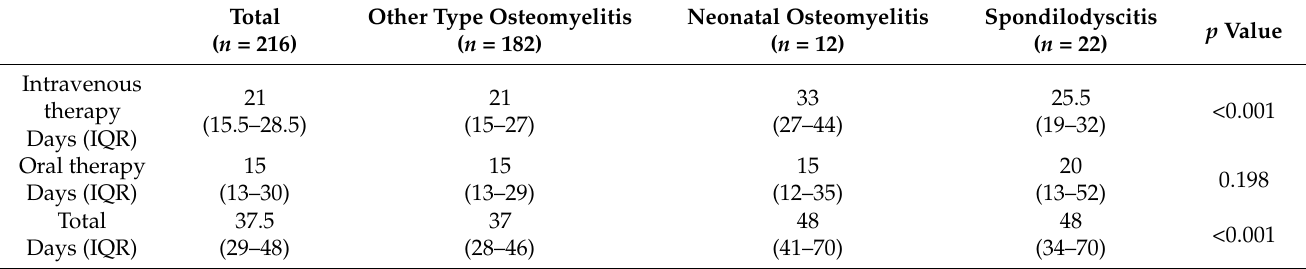
Table 4. Duration of antibiotic